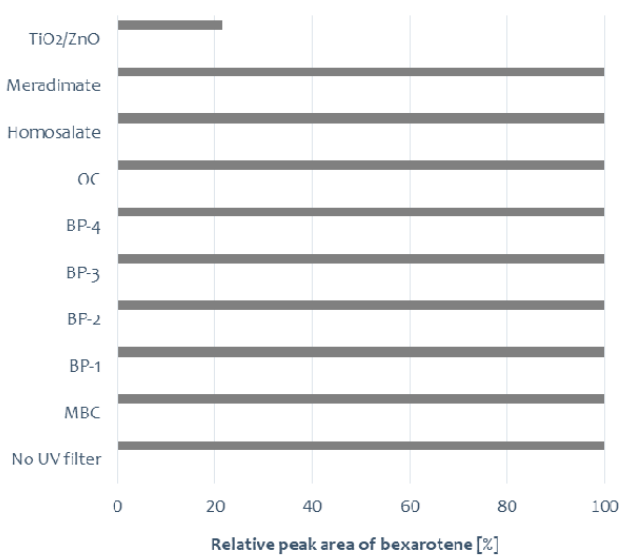
Figure 2. Average relative peak areas of bexarotene after 1 h of UV irradiation in the presence of UV absorbers.